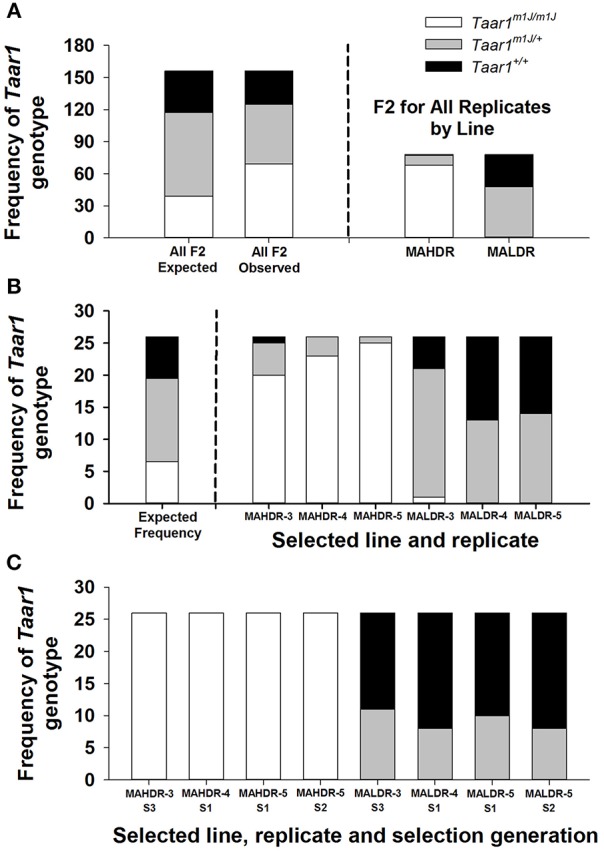
Taar1 genotype frequencies are altered by selective breeding for high and low levels of MA intake, beginning with a founding population of C57BL/6J × DBA/2J F2 mice. Shown in A,B are the frequencies of Taar1 genotypes for F2 mice that were tested for MA drinking and selected to produce the first selection generation (S1) offspring of several replicates of the MADR lines of mice. (A) Expected frequency (based on the null hypothesis of no role for Taar1 in MA intake) and observed frequency of homozygous Taar1m1J (in white), heterozygous Taar1m1J/+ (in gray), and homozygous Taar1+ (in black) mice among all selected F2 breeders (left) and observed frequencies for the F2 breeders separated by selected line (right). (B) Expected Taar1 genotype frequency (left) and observed frequencies for each line and replicate (right). (C)
Taar1 genotype frequencies for the breeders of several replicates and selection generations (Sx) of the MAHDR and MALDR lines.